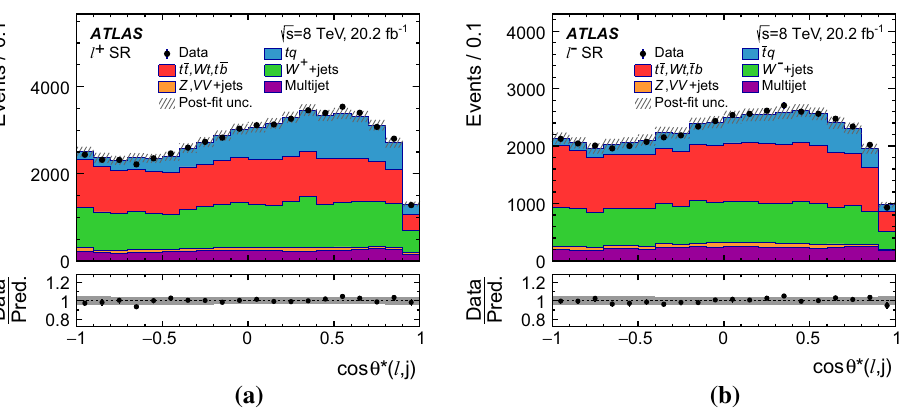
Fig. 8 Observed distributions of cos θ ∗ ((cid:5), j ) in a the (cid:5) + SR and in b the (cid:5) − SR compared to the model obtained from simulated events. The simulated distributions are normalised to the event rates obtained by the fit to the O NN distributions. The hatched uncertainty band represents